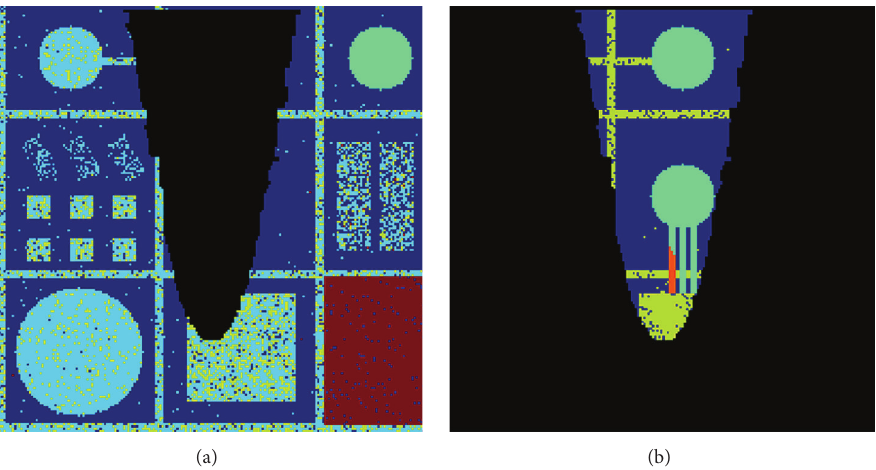
Figure 8: Classification results on the synthetic refinery scene. (a) Plume-absent region. (b) Plume-present region.